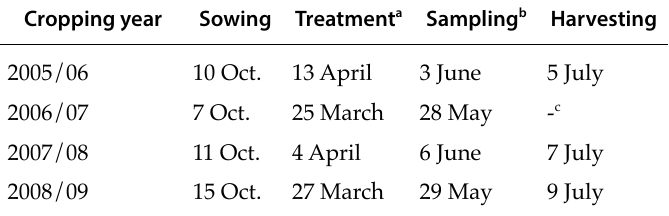
Table 2. Dates of sowing, application of fungicide treatments, sampling and harvesting in consecutive wheat crops. Cropping